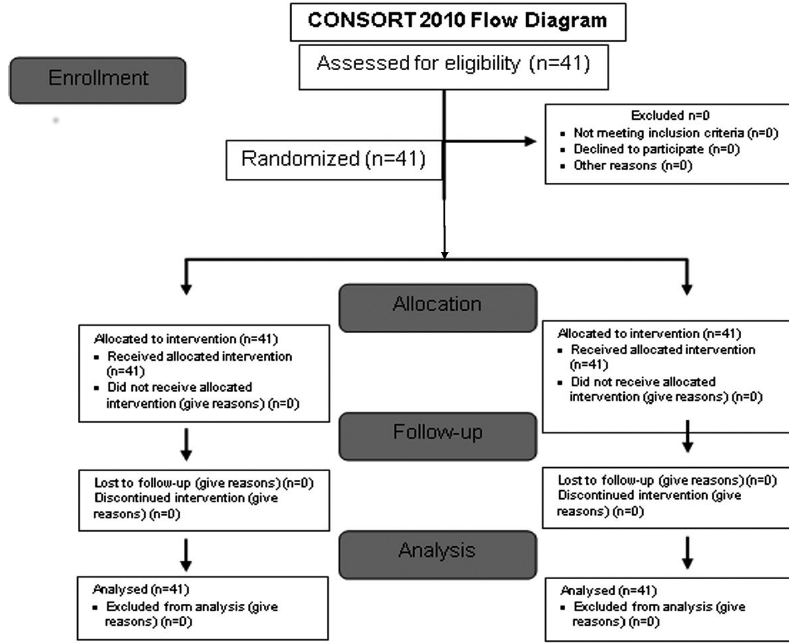
Figure 1- CONSORT flow diagram of patients enrolled in the clinical